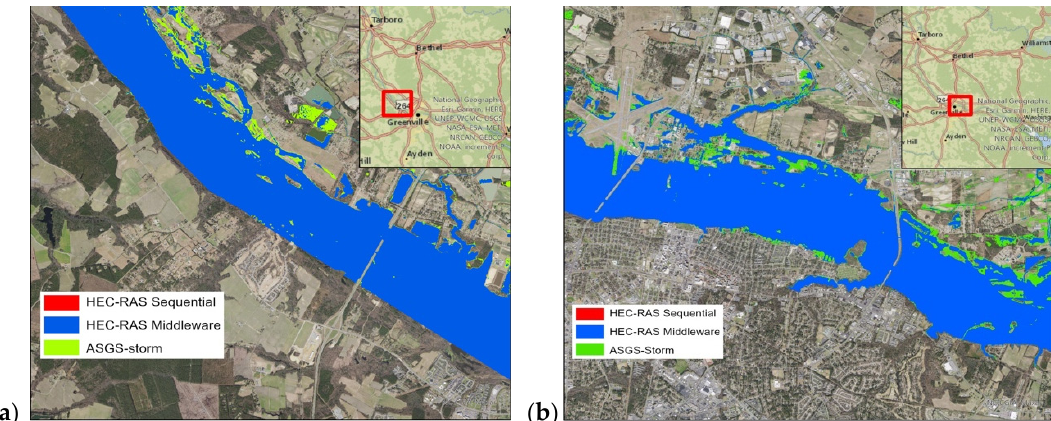
Figure 9. Hurricane Floyd inundation extents for ( a ) Rock Springs, NC, and ( b ) Greenville, NC. The red boxes in the inset figures indicate the location within the river.